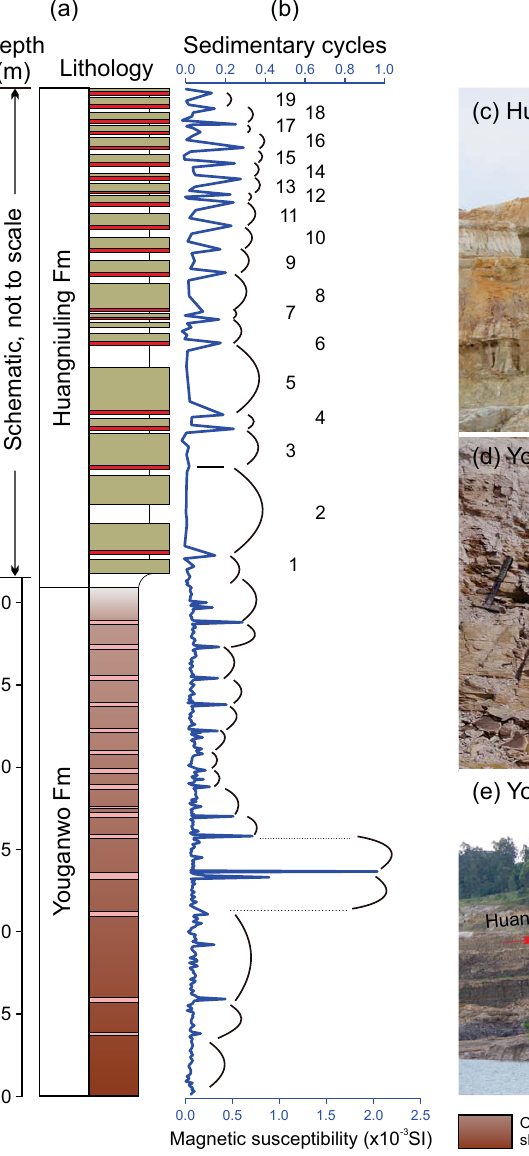
www.clim-past.net/12/255/2016/ Clim. Past, 12, 255–272,